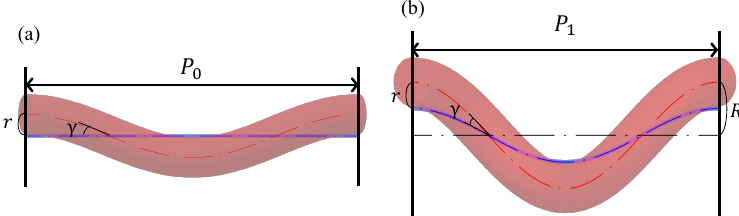
Figure 3. Device model with one helix cycle that focuses on the body axis and one of the three silicone tubes that helically wrap around the body. ( a , b ) show the device before deformation and after deformation,